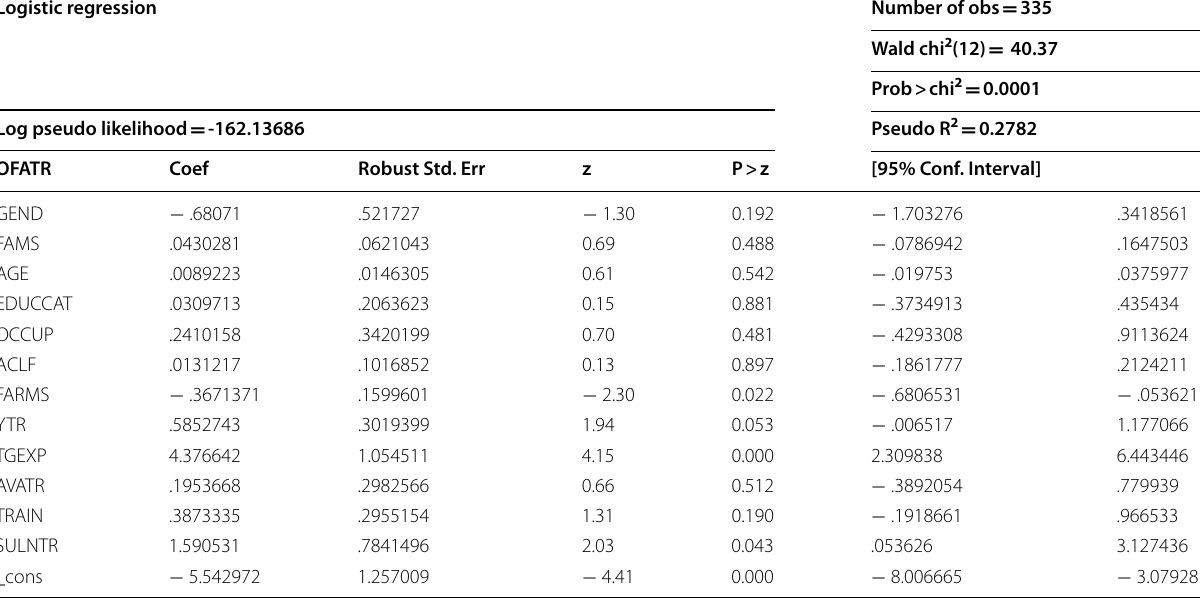
Table 8 Estimates of logistic regression without agro-ecological dummies